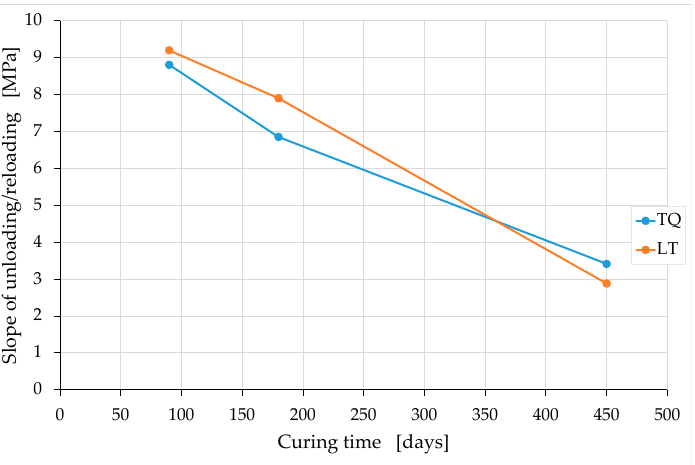
Figure 23. Trend over time of the average values of the unloading–reloading slope (TQ and LT mixes): the unloading–reloading slope is the slope of the last stabilization cycle.